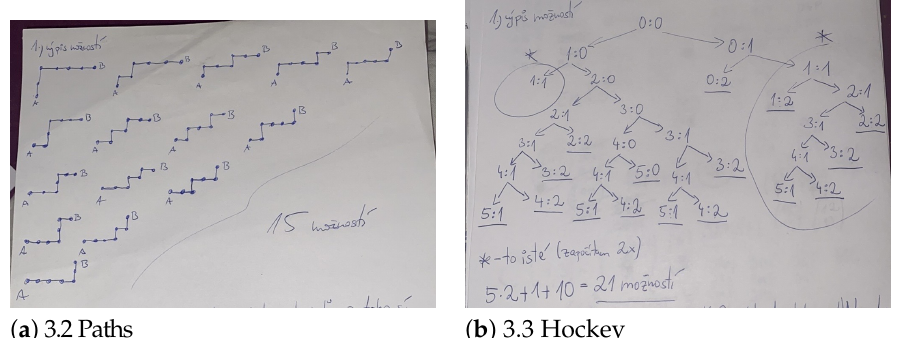
Figure 12. Representation depends on the context of the